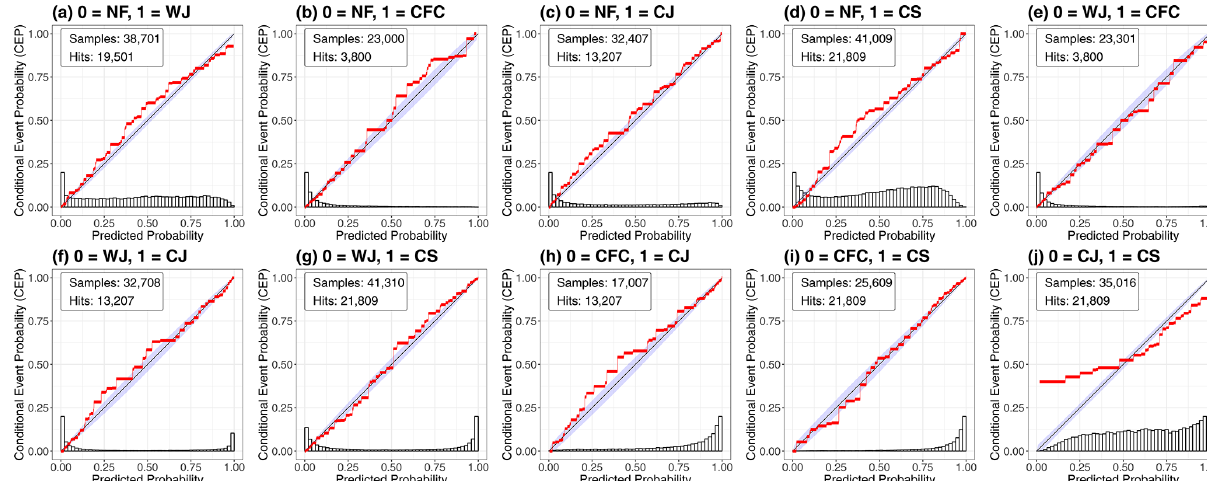
Figure D3. As in Fig. 7 but based on COSMO-REA6 data.